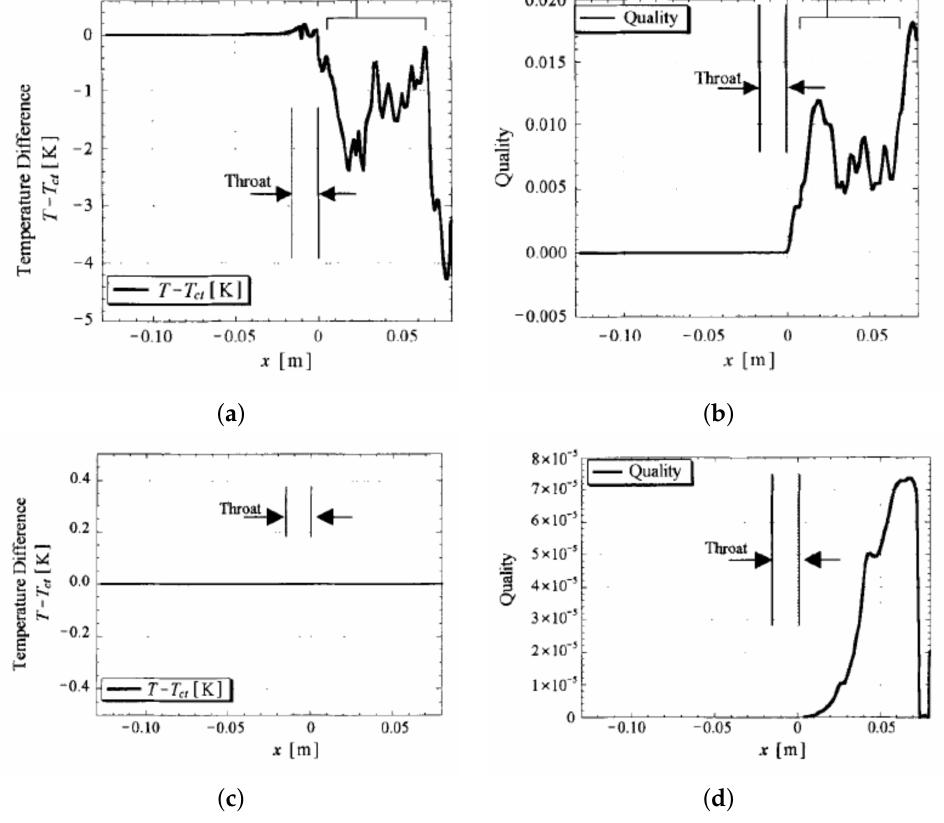
Figure 3. Temperature and quality distribution along the tested nozzle in [20] for LN 2 ( a , b ) and for H 2 O ( c , d ); temperature is unaltered by the flow quality for H 2 O whereas it is inversely proportional to the quality for LN 2 . Reprinted from [20], Copyright(1969), with permission from Springer